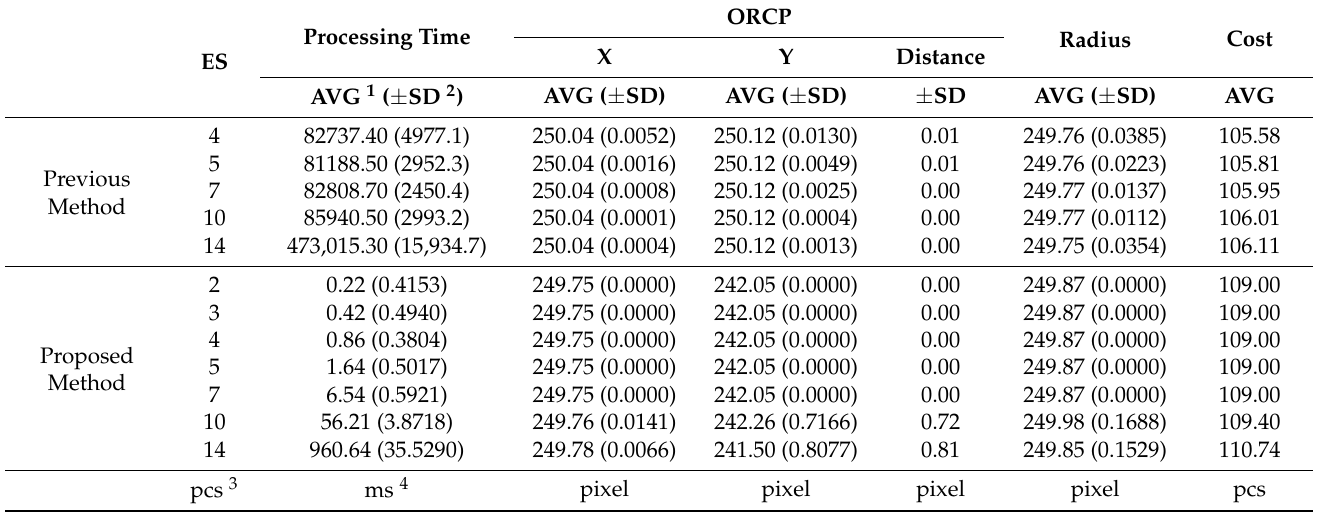
Table 1. Performance of HPOM estimation according to the number of ES.